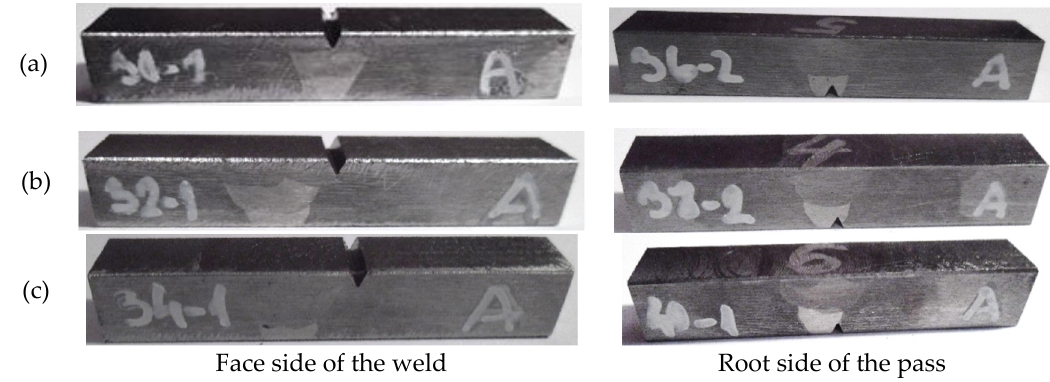
Face side of the weld Root side of the pass Figure 7. Positions of the notch on samples for the impact toughness testing: ( a ) Along the weld metal axis; ( b ) in the fusion zone; ( c ) in the HAZ.